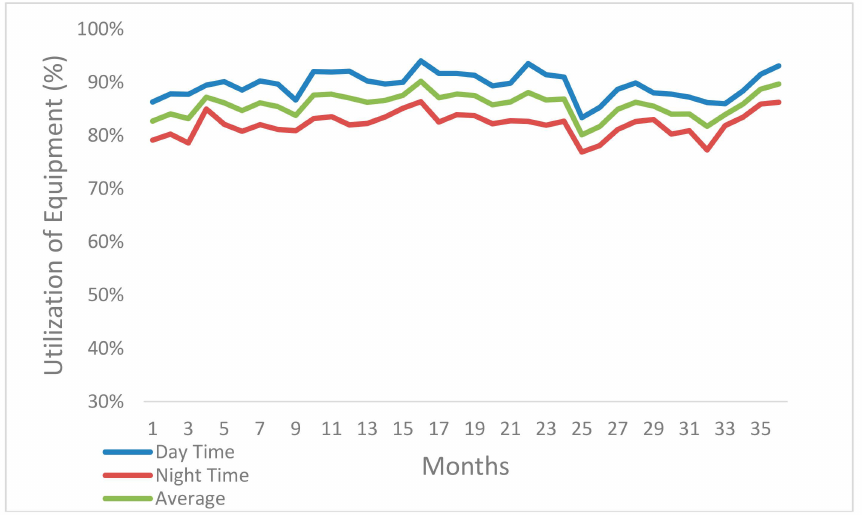
Figure 7. Monthly Yard Equipment Operation Rate (%) over 3 years